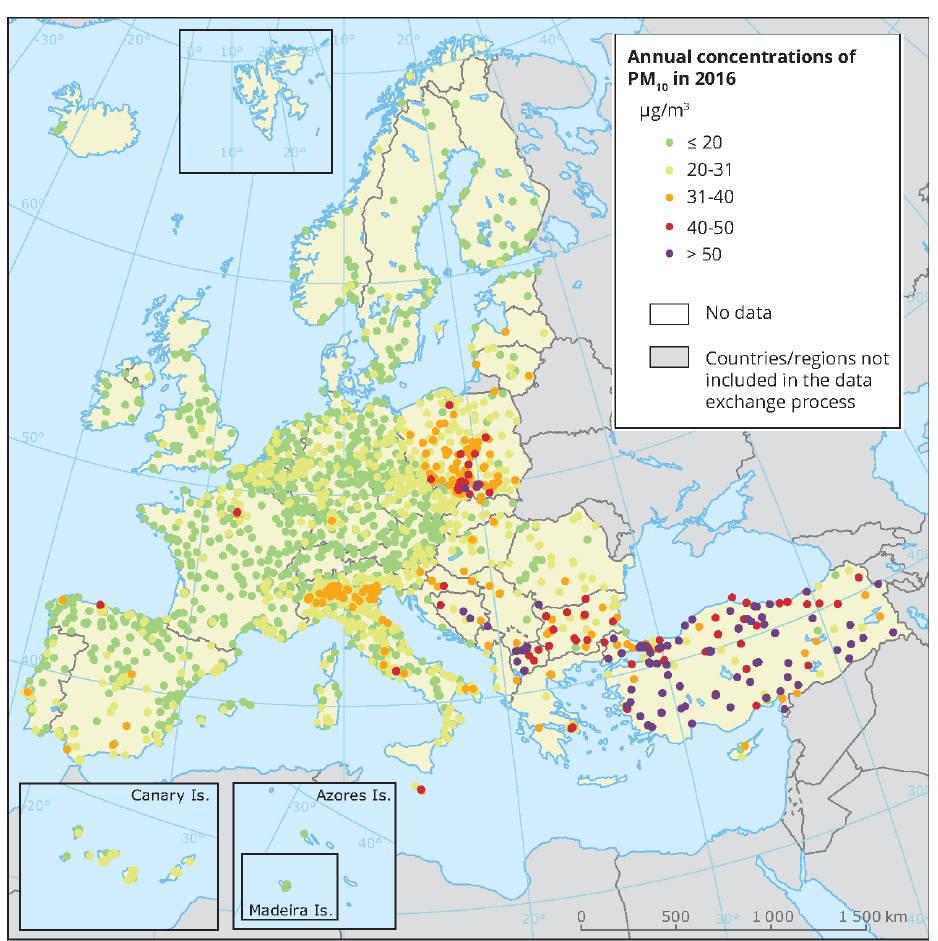
Figure 1. Annual mean concentration of PM 10